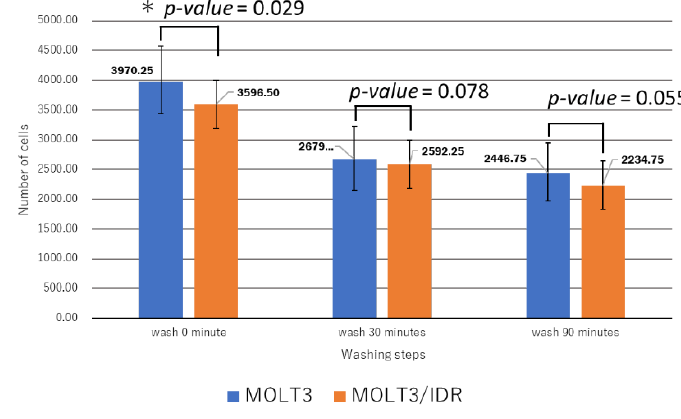
administration, the MOLT-3/IDR cells treated with 0.5 µ g/mL IDR showed slow IDR permeability.